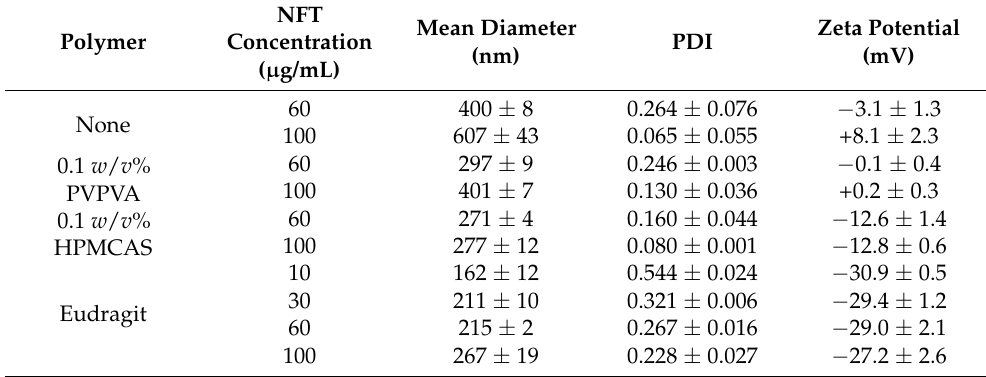
Table 2. Particle size and zeta potential of NFT/polymer nanostructures.